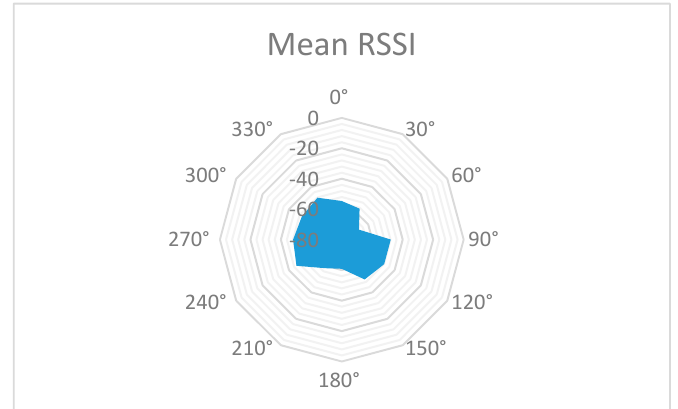
Table 4. Statistical analysis of RSSI measurements. Angle (DEG)